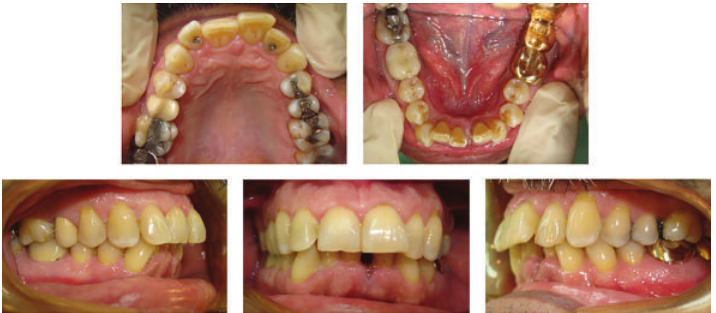
Figure 2: Intraoral composite photographs following the extraction of the mandibular left central